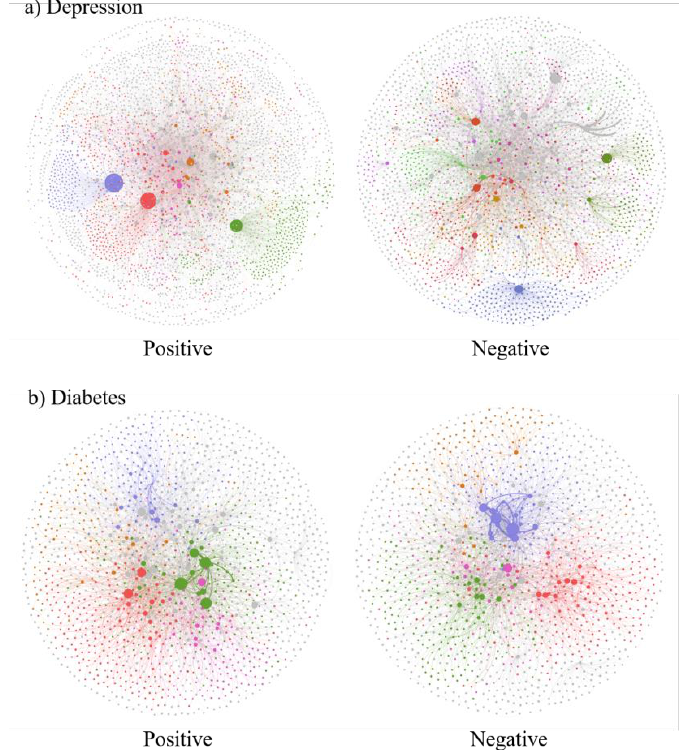
Figure 9. Positive and negative emotional contagion networks in online ( a ) depression and ( b ) dia- betes communities. ( b ) diabetes